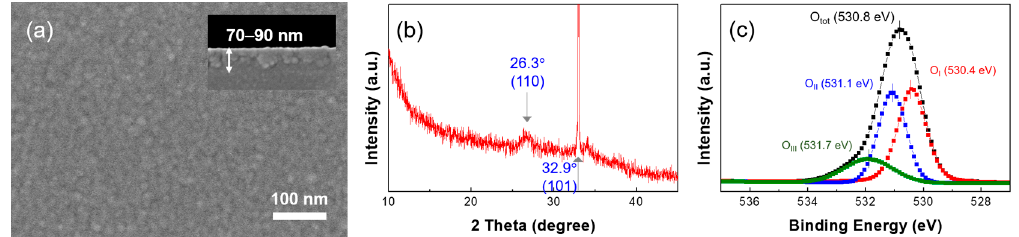
Figure 9. ( a ) FE-SEM images; ( b ) XRD pattern; and ( c ) O 1 s XPS spectra of the Ga:Sn oxide film fabricated at the annealing temperature of 900 °C.